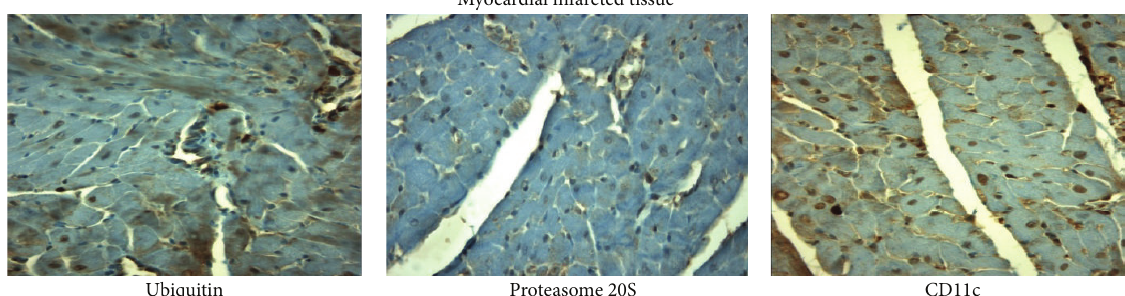
Figure 3: Consecutive immunostaining (X200) using serial sections of infarcted myocardial tissue demonstrated that cells positive for CD11c were also positive for proteasome 20S and